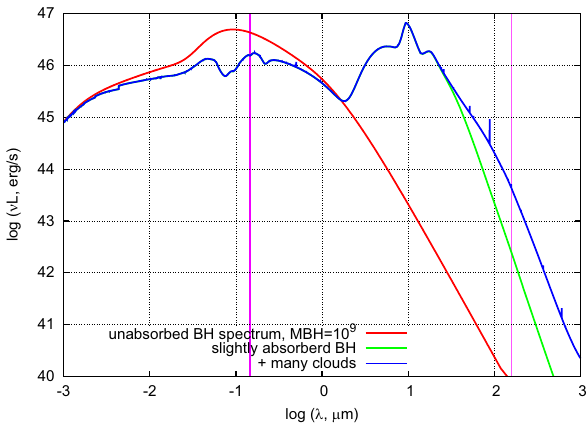
Figure 1: Spectral energy distributions for the Kubota and Done ( 2018 ) model of an unabsorbed SMBH with = Eddington accretion rate ( red line ) , a slightly absorbed SMBH ( green line ) , and with absorption by small clouds ( blue line ) . Two vertical magenta lines mark the wavelengths 1,450 Å and 158 μm